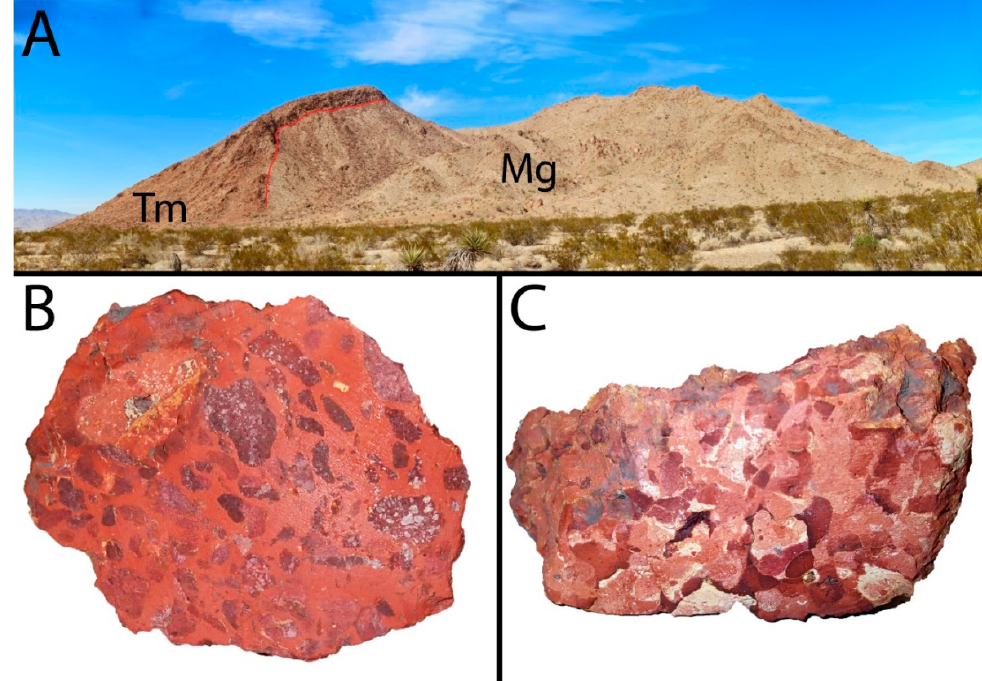
Figure 2. A . Field photo of basal Tertiary nonconformity at the base of the Maniobra Formation field site, Orocopia Mountains, California. Approximate location of unconformity marked with thin red line. Tm = Tertiary Maniobra Formation. Mg = Mesozoic plutonic basement of the Orocopia Mountains. B and C . Photos of deeply weathered basement rocks from bedrock beneath the unconformity at the base of the Ione Formation, Ione, California. The coloration, texture, and mineralogy observed in hand samples is consistent with the putative inference of intense chemical weathering found in the geologic literature, as well as the reflectance signatures found in this work.